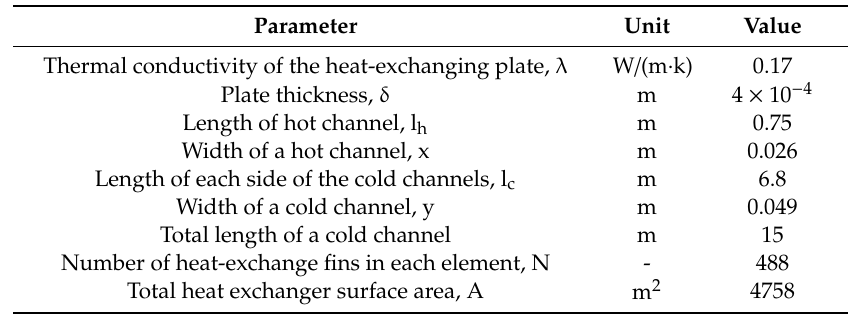
Table 1. Design parameters of the confined space cooling tower (CSCT)-type vapor-condensing plume abatement (VCPA) device.